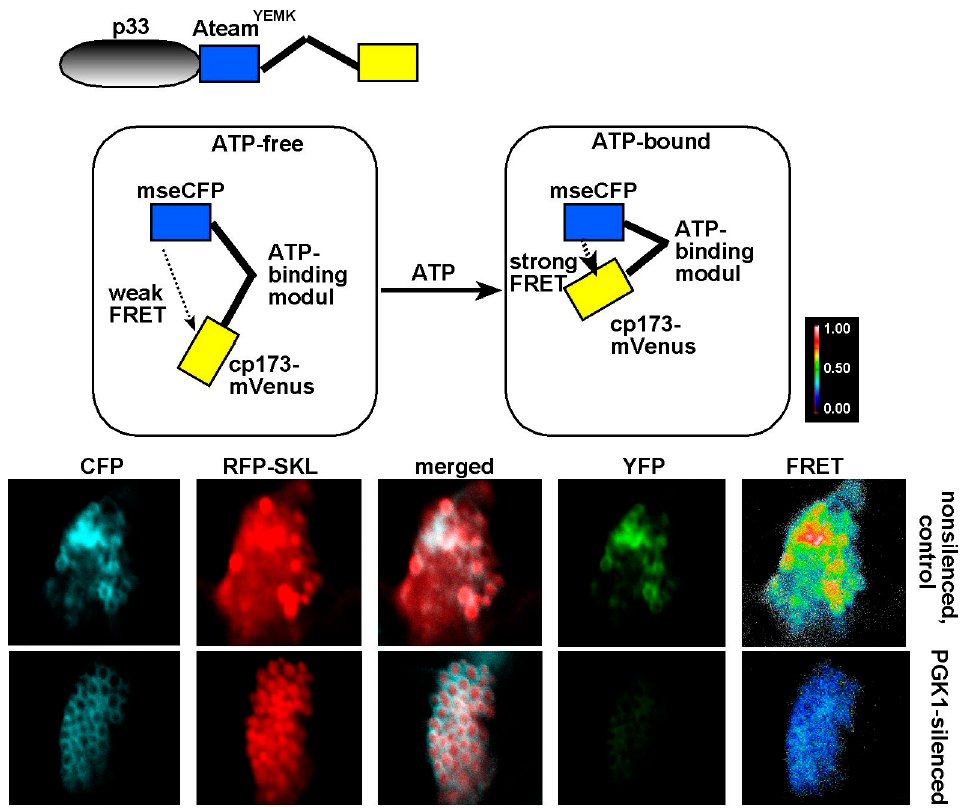
Figure 1. Knockdown of cellular Pgk1 glycolytic enzyme inhibits ATP accumulation locally within tombusvirus viral replication compartments or replication organelles (VROs) in N. benthamiana . Top: Schematic representation of the FRET-based detection of ATP within VROs. The ATP biosensor, ATeam YEMK was fused to Tomato bushy stunt virus (TBSV) p33 replication protein. The dotted line indicates energy transfer between the modules. Bottom: Confocal microscopy images of VROs in plant cells show the low ATP level within the VRO when Pgk1 expression is silenced. Pgk1 mRNA level was knocked-down in N. benthamiana and the ATP level was detected via expression of the p33-ATeam YEMK biosensor. The YFP signal was generated via FRET. The more intense FRET signals are white and red (between 0.5 to 1.0 ratio), whereas the low FRET signals (0.1 and below) are light blue and dark blue. N. benthamiana plants were infected with TBSV, which replicates on peroxisomal membranes. CFP signal detects large TBSV VRO, which is also marked by the RFP-SKL peroxisomal marker. See further details in [33].